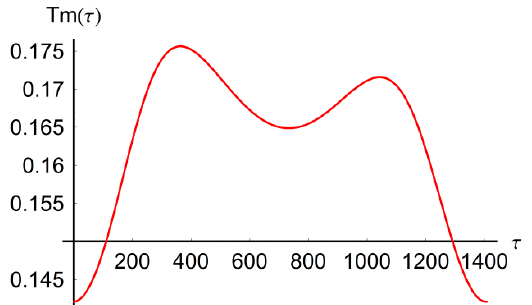
Figure 4. Variation in mechanical torque of the wind turbine during the wind gust.